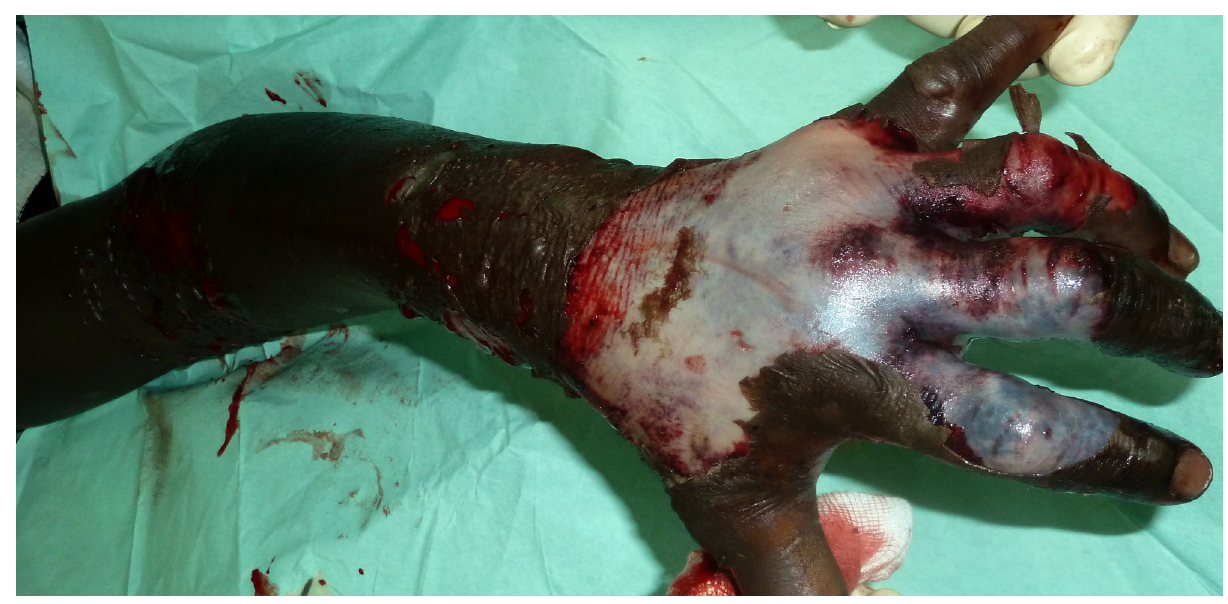
Figure 7. Initial aspect of the left hand, second